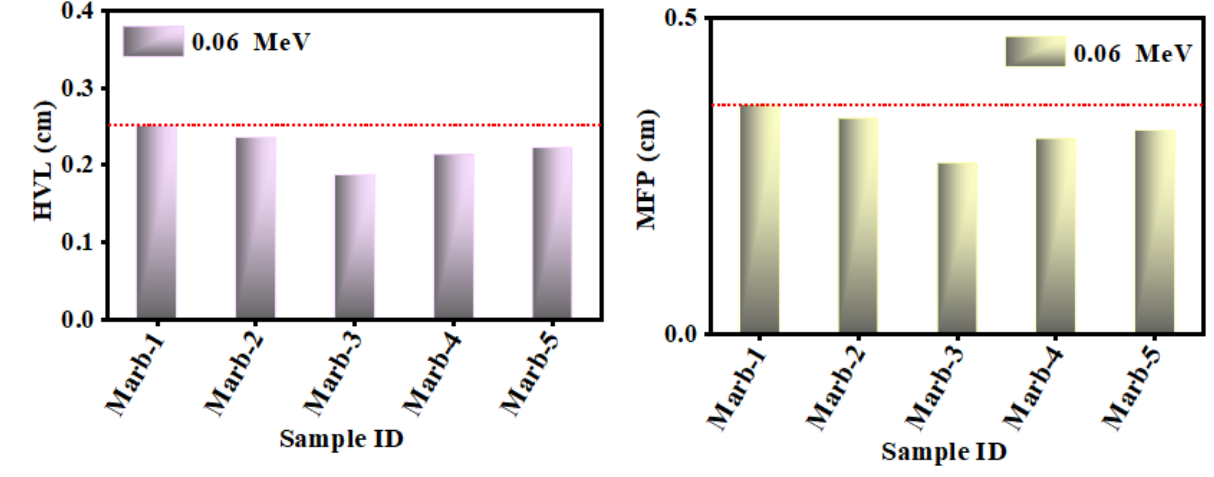
Figure 10. The value of the HVL and MFP of the prepared composites at energy 0.06 MeV. Equivalent atomic numbers (Z eq ) of the innovative polyester samples (polyester/waste marble/PbCO 3 /CdO) are displayed in Figure 11. Within the energy limit of 0.015 MeV